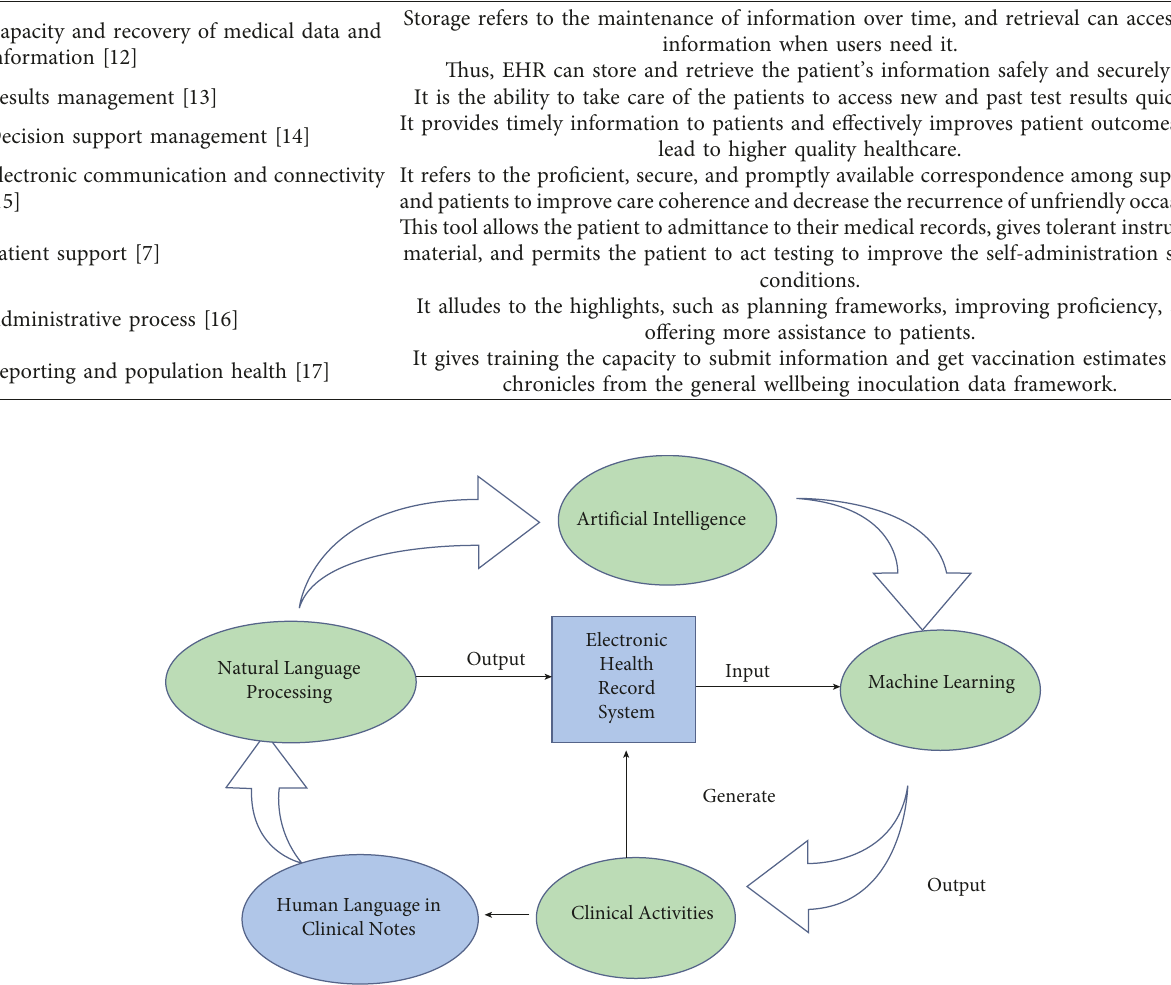
Figure 7: Role of AI in EHR